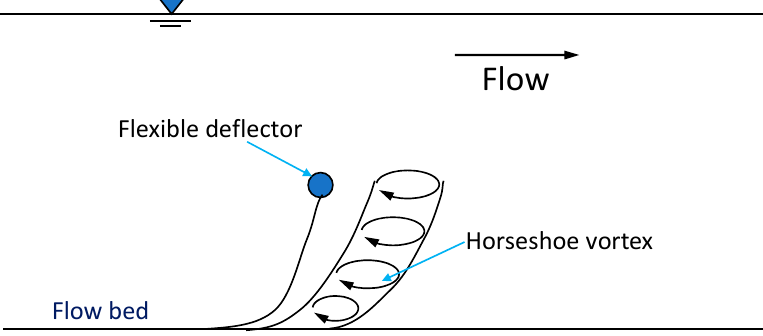
Figure 8. Scheme of the upward stretching and enlarging horizontally rotating vortex.